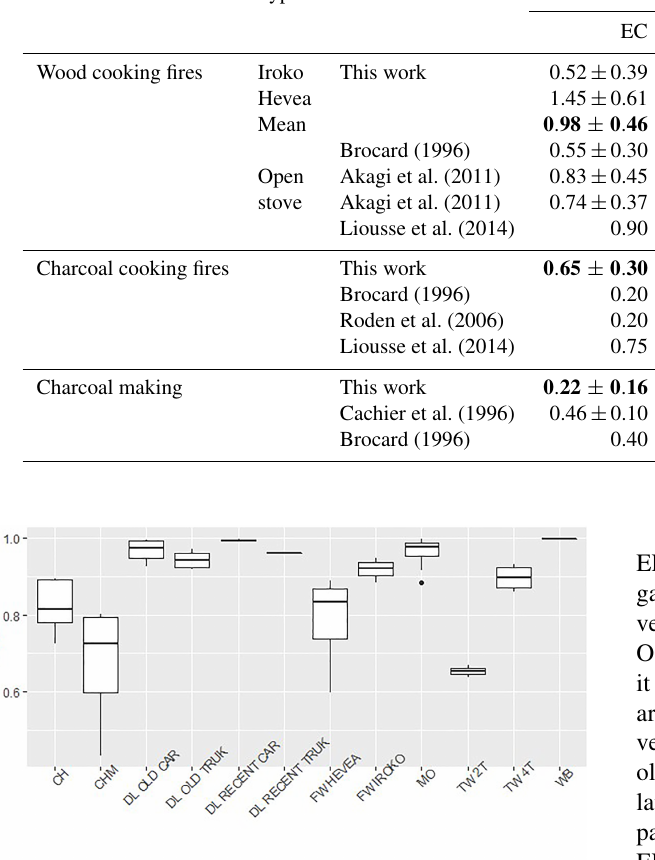
Table 1. EFs of residential sources for this study and those from the literature (mean values from this study in bold). Emission